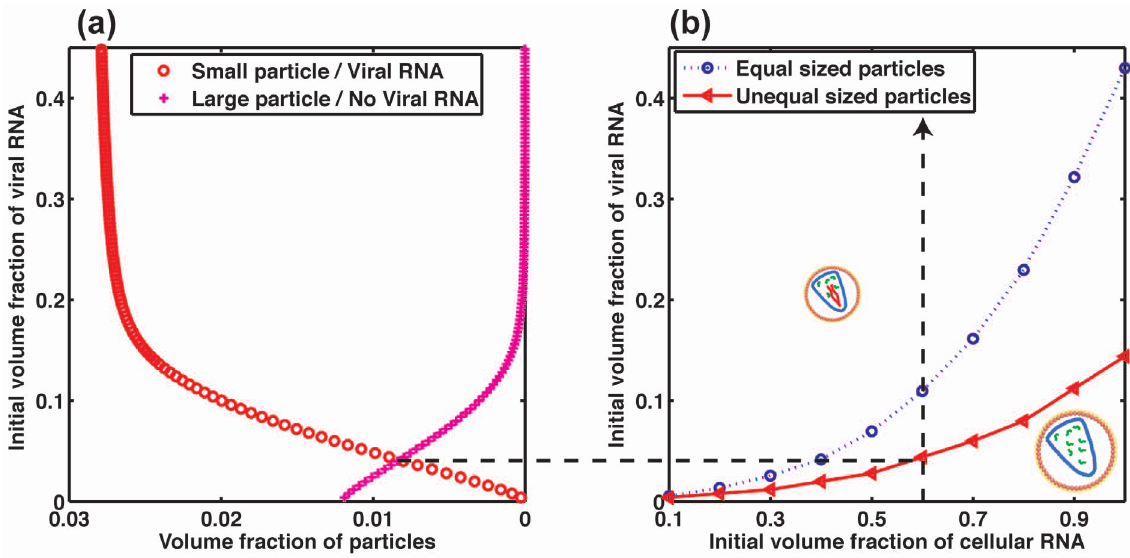
Figure 6. Combined model of viral genome and particle size entropic selection. The model is specialized to bimodal products of self- assembly, with different particle size and different RNA content. (a) Typical large RNA titration computed thanks to the model detailed in File S1. The value of parameters chosen for the calculation are found in the material and methods . In this case, the number of proteins in the ‘‘large particles’’ is twice the number of proteins in the small one. Red circles correspond to small particles with large RNA, and pink crosses correspond to large particles lacking large RNA. (b) Phase diagram small RNA/large RNA . The boundary for which the concentration of both particles are equal is shown by red filled circles. The line joining the circles is drawn to guide the eye. For comparison, the boundary at fixed particle sizes found in figure 5b is depicted by a blue dotted line.